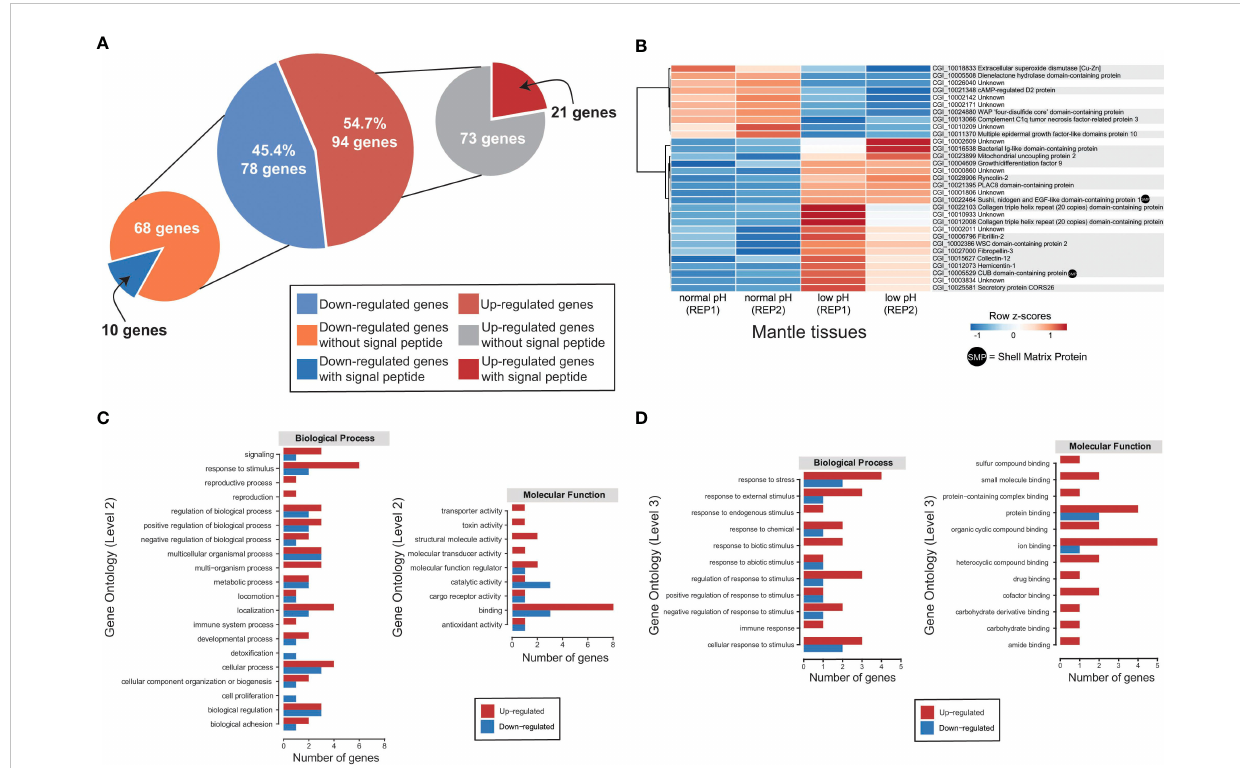
FIGURE 4 Transcriptomic response of mantle cells of oysters exposed to ocean acidi fi cation condition. (A) A total of 172 genes were identi fi ed as differentially expressed in adult oysters reared under normal (8.0 ± 0.2) and low (7.6 ± 0.2) pH conditions and placed into two categories according to the presence or absence of a signal sequence. (B) Heatmap of signi fi cantly differentially expressed genes encoding secreted proteins. At the bottom of each column is depicted the mantle tissue and the corresponding pH condition used to generate the RNA-Seq data. Genes are displayed as horizontal rows clustered by similar expression pro fi les, represented by the dendrogram to the left of the heatmap. Red indicates higher expression, while blue illustrates lower expression. Gene annotations are indicated to the right of the heatmap, and gene products (proteins) that have been previously identi fi ed as part of the organic matrix of larval/adult shells are indicated by a black dot. (C) Distribution of differentially expressed genes encoding secreted proteins with annotated biological process GO terms (Level 2) and molecular function GO terms (Level 2). See Supplementary Table 4 for gene name information. (D) Distribution of differentially expressed genes encoding secreted proteins with annotated biological process GO terms (Level 3) and molecular function GO terms (Level 3). See Supplementary Table 5 for gene name